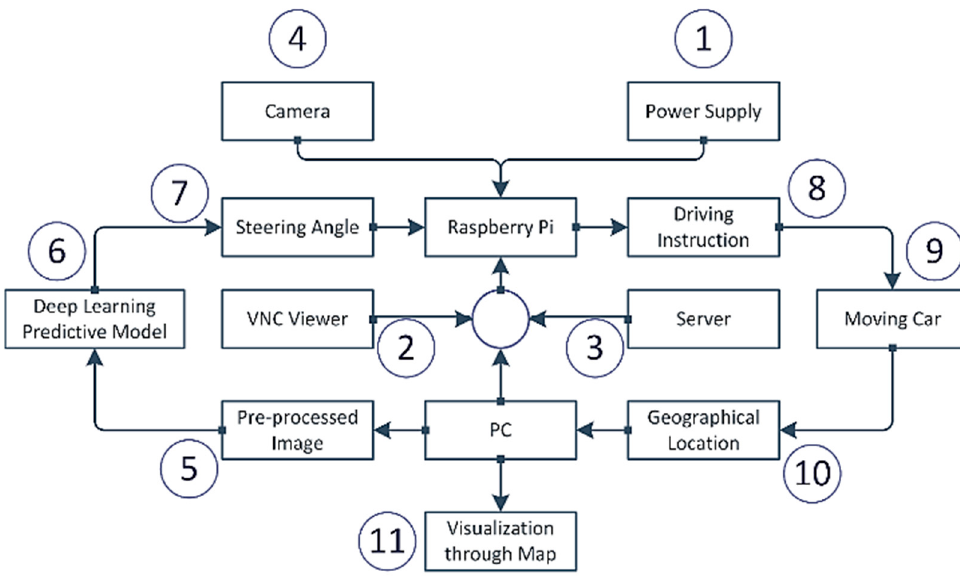
Figure 6. The overall design of the system. Because of the low processing power of the raspberry pi, per second, only ten images have been sent to the local pc. After receiving the image, the image goes through the pre-processing steps that include removing the upper part of the image, blurring the